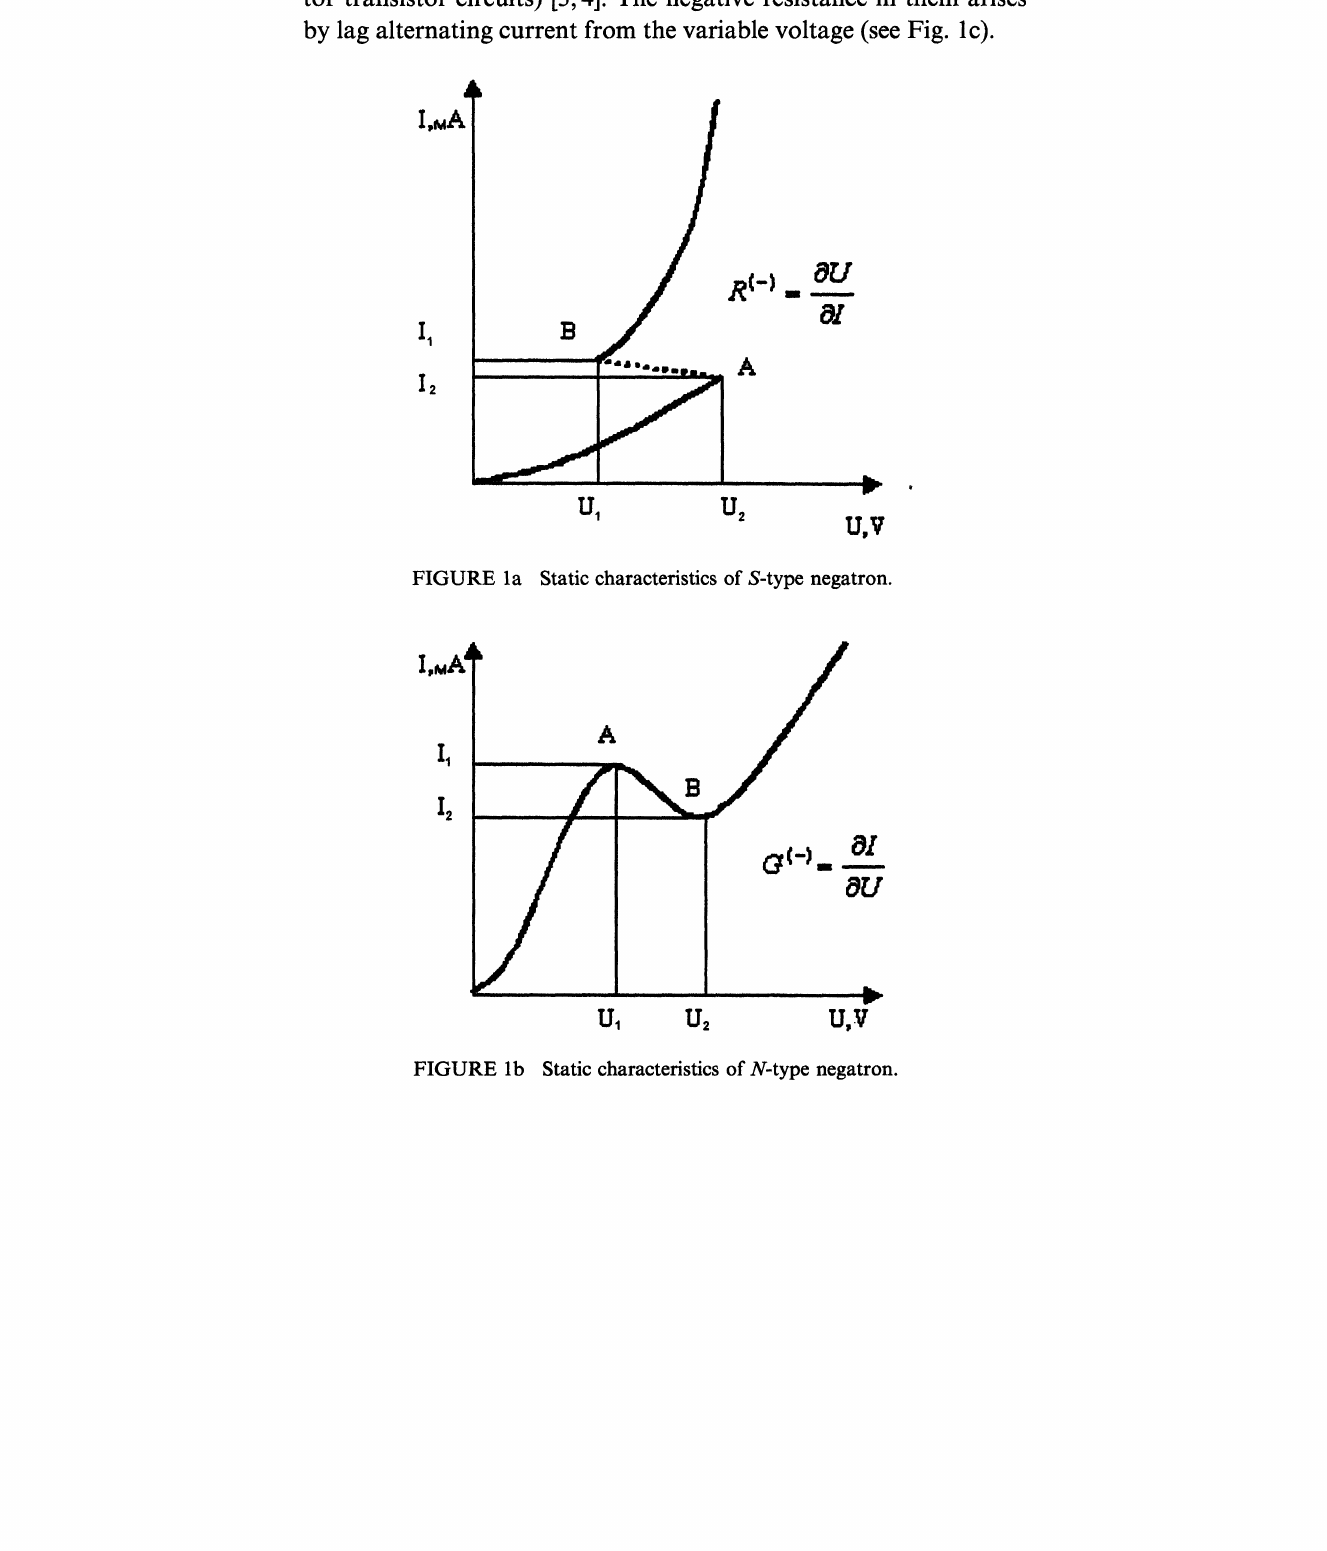
FIGURE la Static characteristics of S-type negatron.